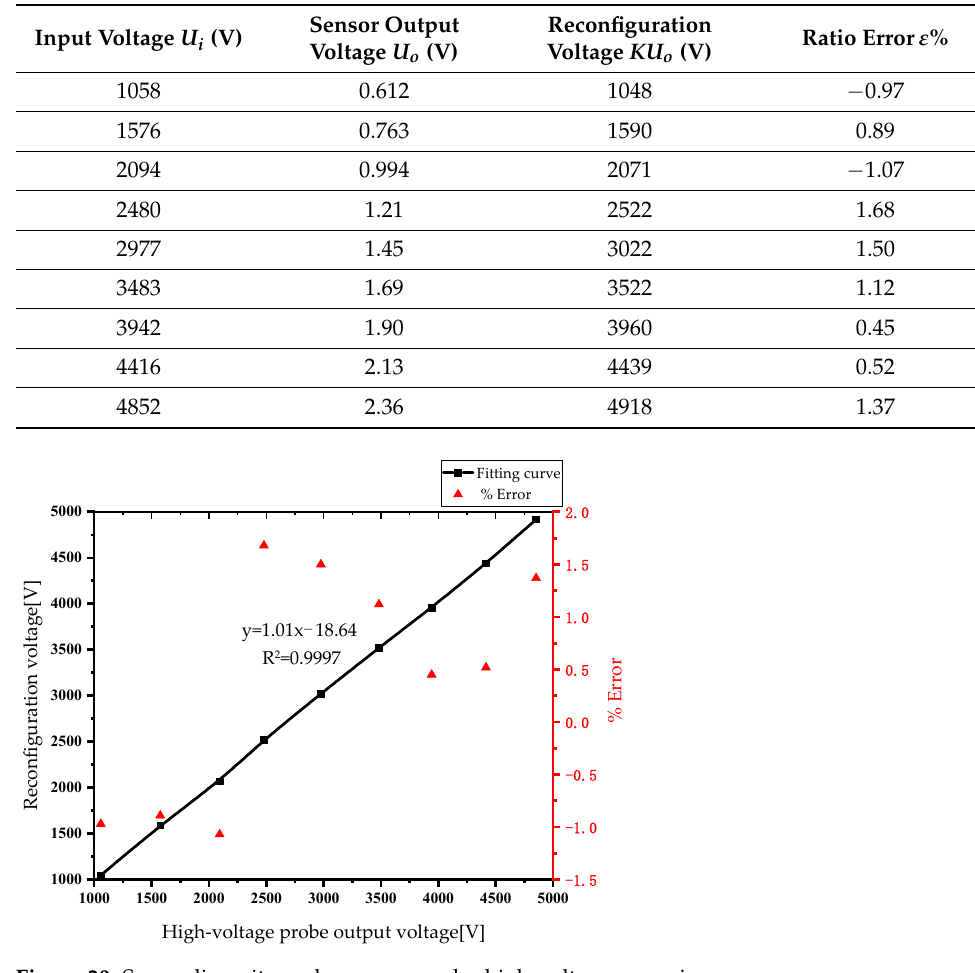
Table 5. Comparison of di ff erent measurement systems.